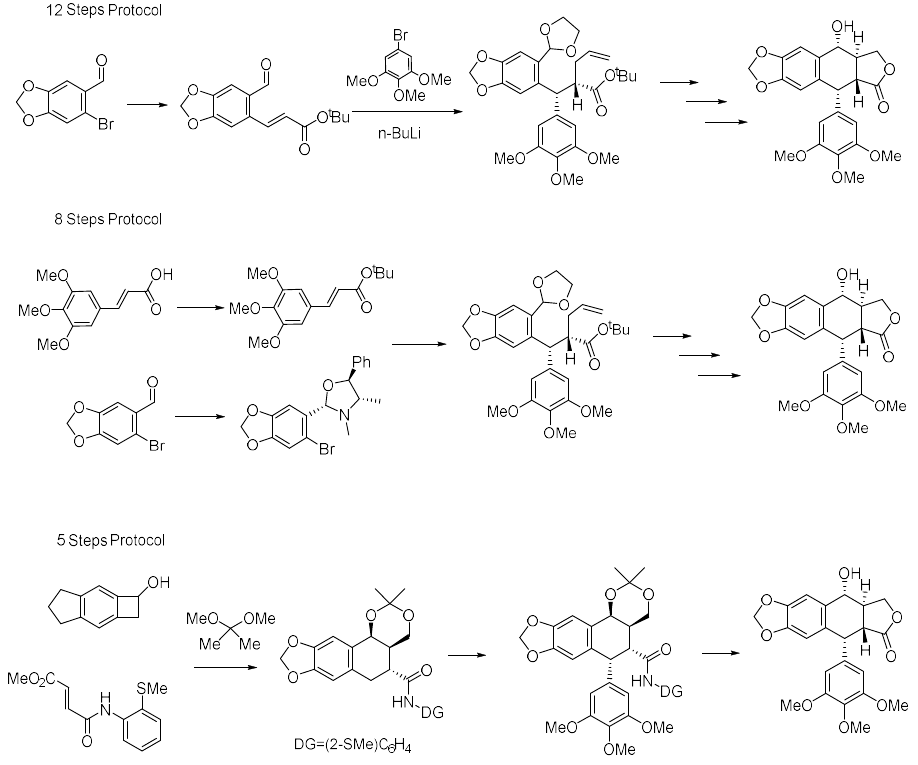
Figure 11. Total chemical synthesis of podophyllotoxin.